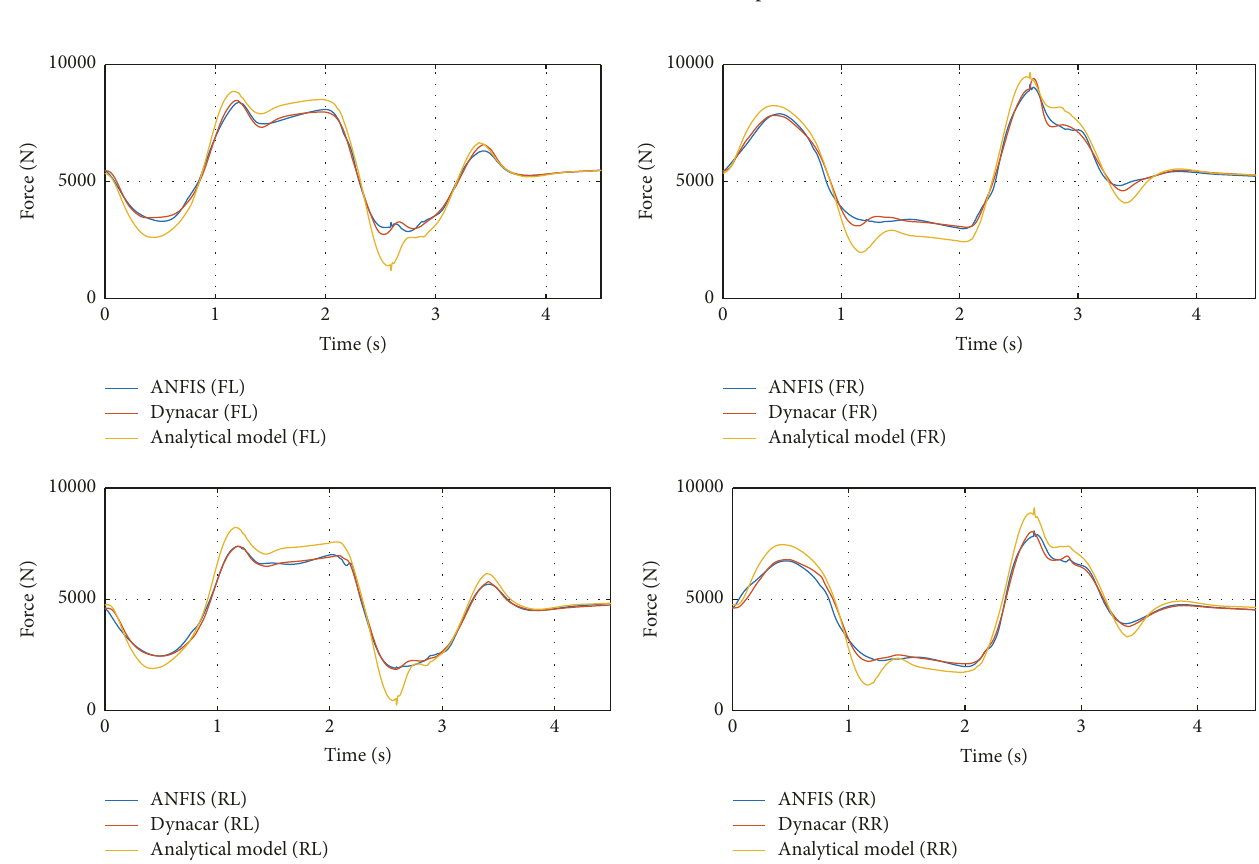
Figure 10: 𝐹𝑧 estimation, double lane